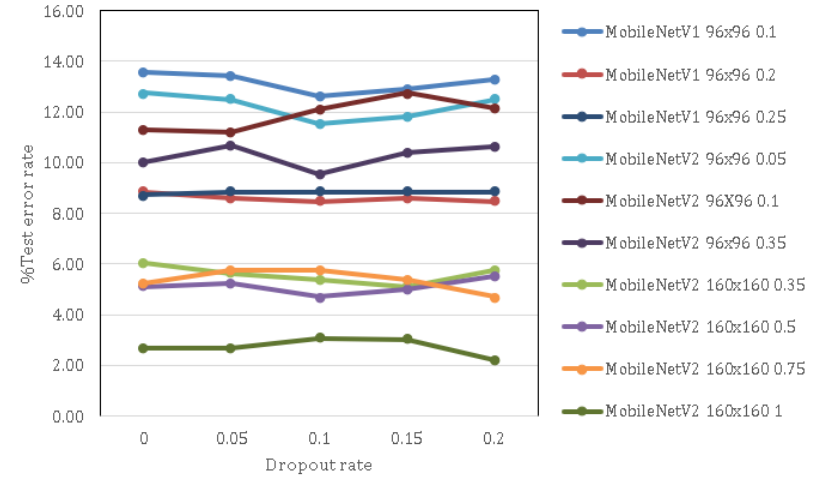
Figure 6. Effect of dropout rate on model performance for the tested MobileNet architectures.